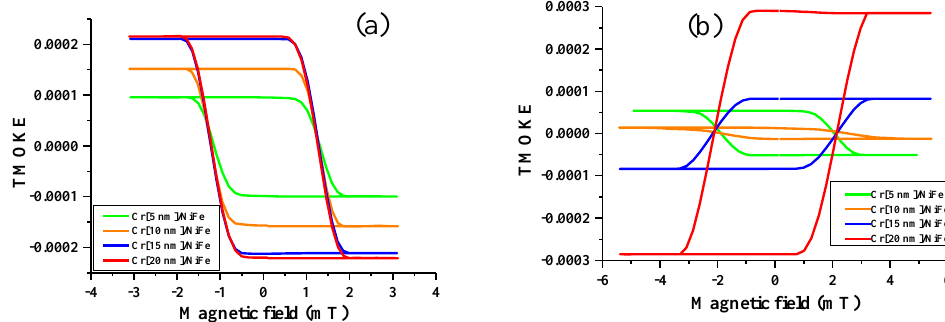
Figure 7. TMOKE hysteresis loops with an in-plane applied magnetic field at two different incidence angle Cr/NiFe films, with different thicknesses of the Cr film and the thickness of NiFe fixed to 10 nm: ( a ) at 30° and ( b ) at 50°.